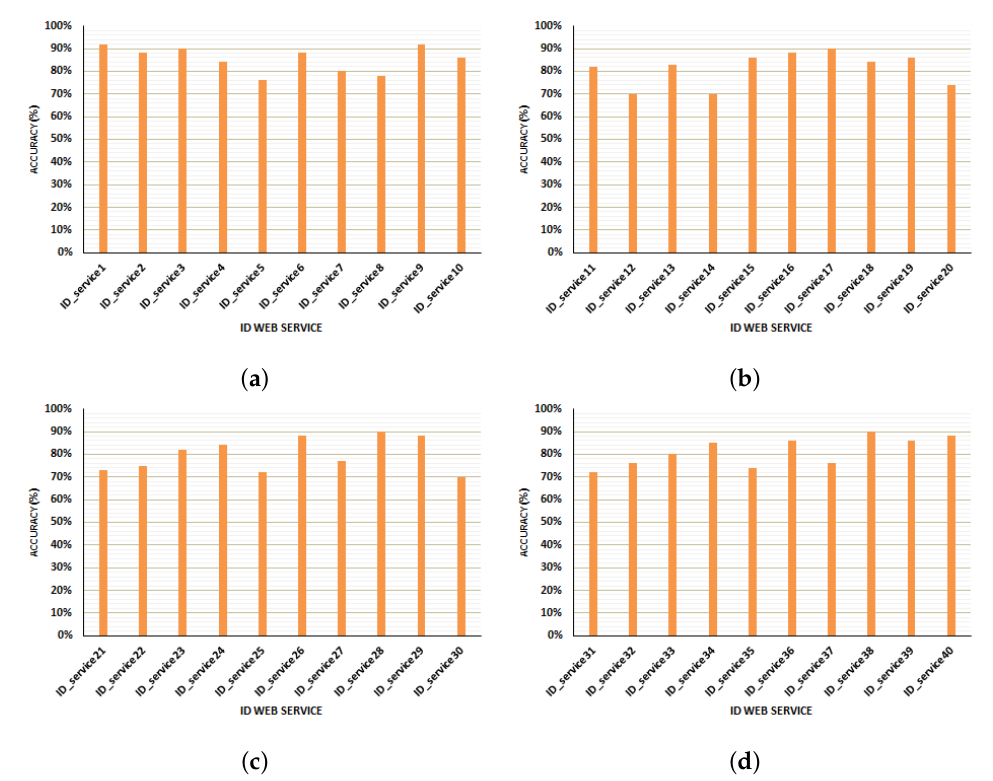
Figure 4. The prediction algorithm evaluation results in terms of accuracy. ( a ) web service 1–10; ( b ) web service 11–20; ( c ) web service 21–30; ( d ) web service 31–40.